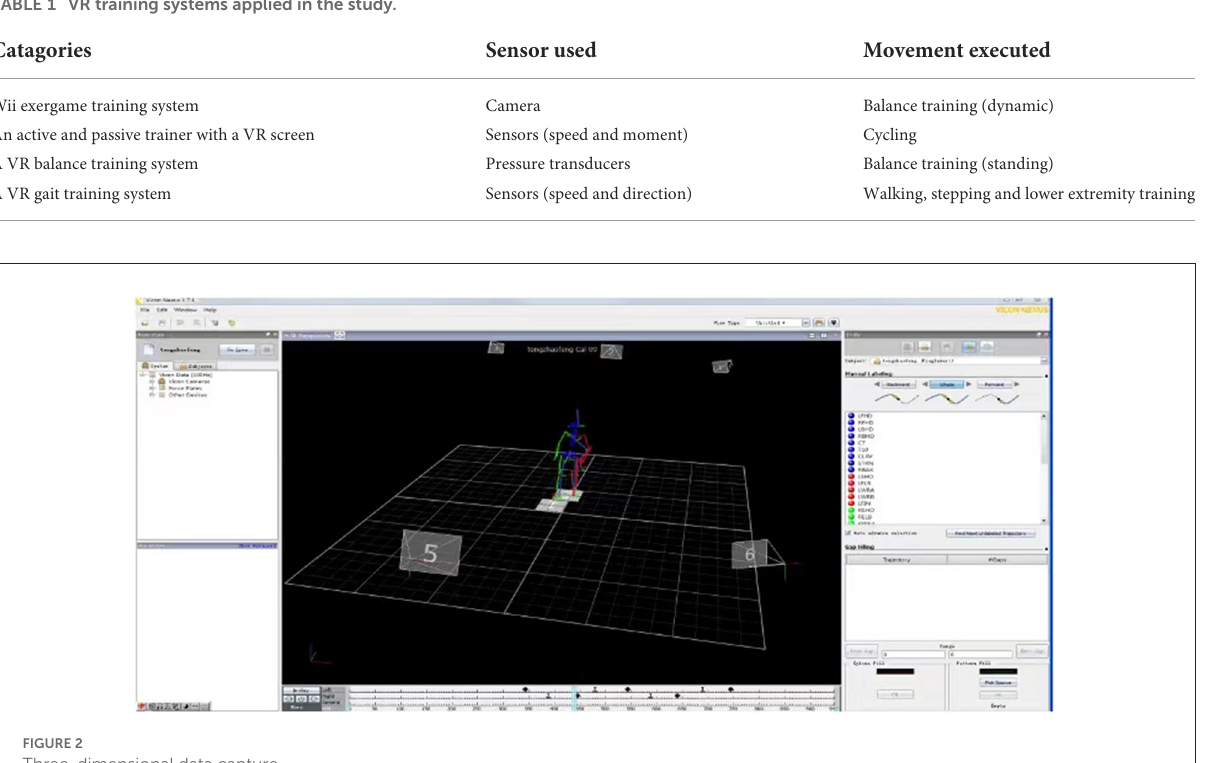
TABLE 1 VR training systems applied in the study.